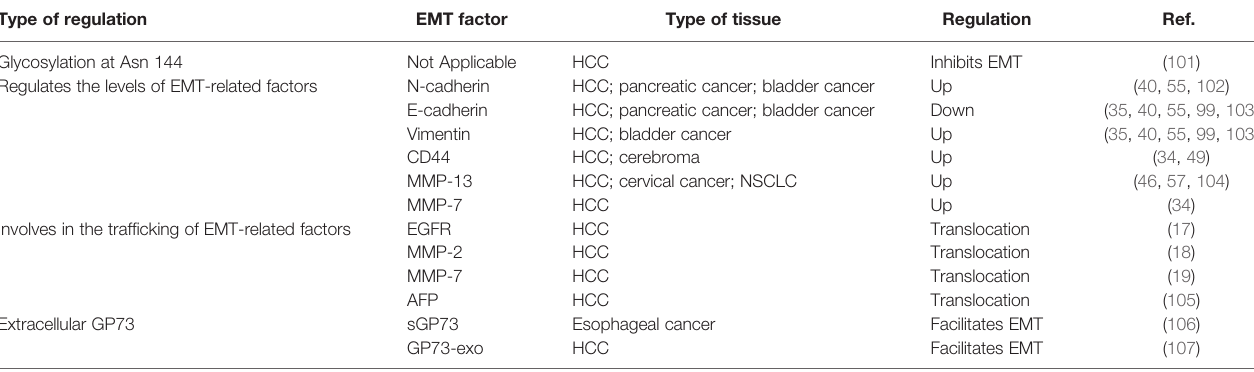
TABLE 4 | GP73 regulates expression and traf fi cking of EMT-related factors and facilitates cancer metastasis. Type of regulation EMT